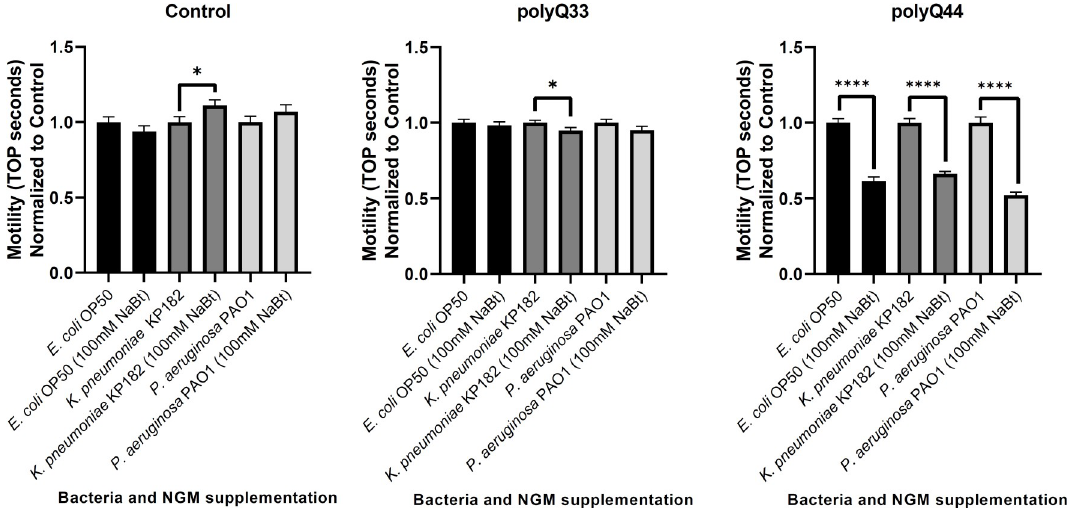
Fig 5. The effect of butyrate on toxicity associated with bacteria-mediated intestinal polyQ aggregation. Aggregation-dependent toxicity is assessed by measuring motility (TOP phenotype) in the presence of 100 mM butyrate. Data are represented as the average number of TOP seconds per worm normalized to the control (0 mM butyrate). Two roller strains, Control (AM446, no polyQ) and polyQ33 (no aggregates), are controls. Each bar is an average of three independent experiments with a total of 60 animals. Error bars represent SEM. Statistical significance between each pair was calculated using Student’s t-test ( � p < 0.05, ���� p < 0.0001).